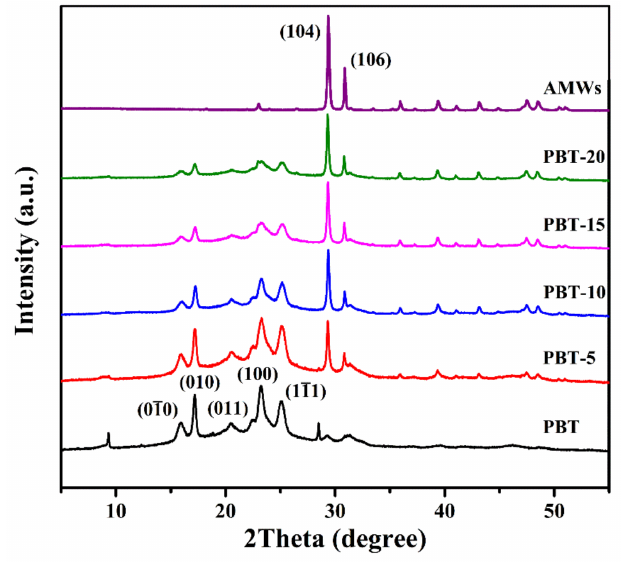
Figure 3. XRD patterns of PBT, PBT/AMWs composites and